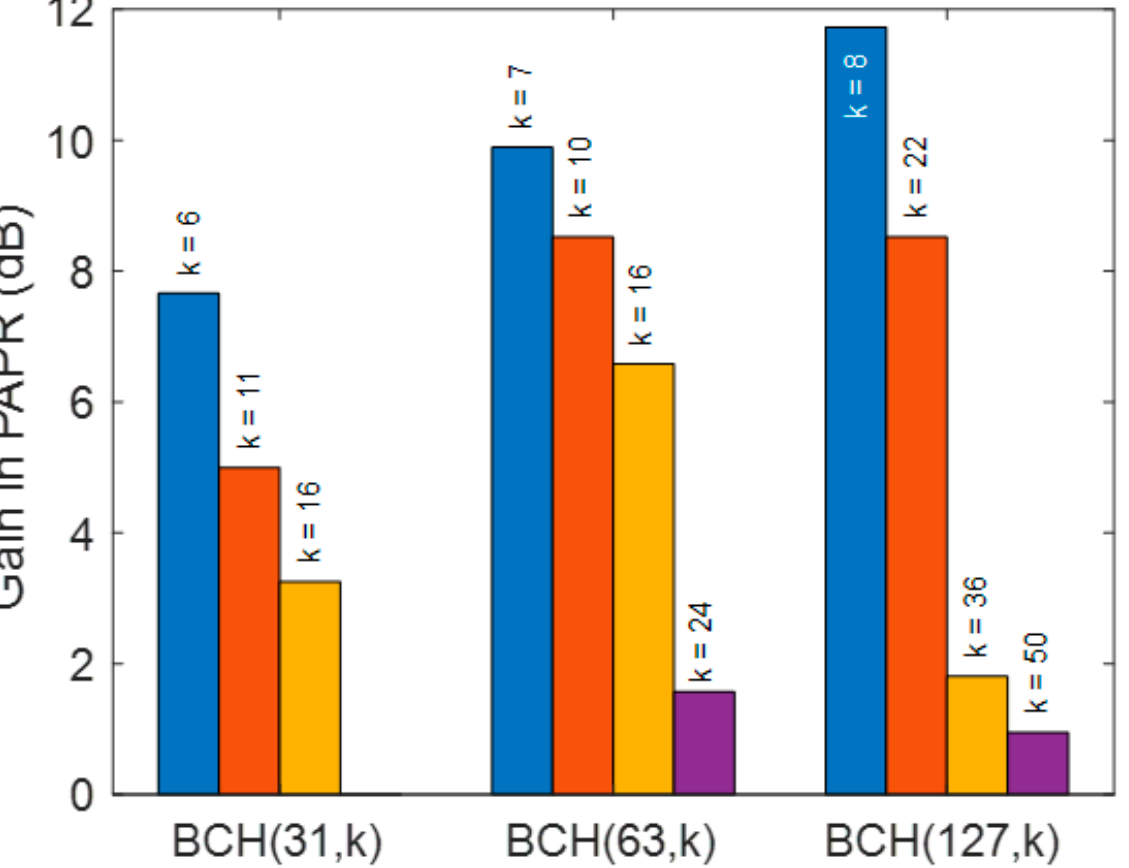
Figure 7. Gain in maximum PAPR as a function of various ciphered BCH codes.